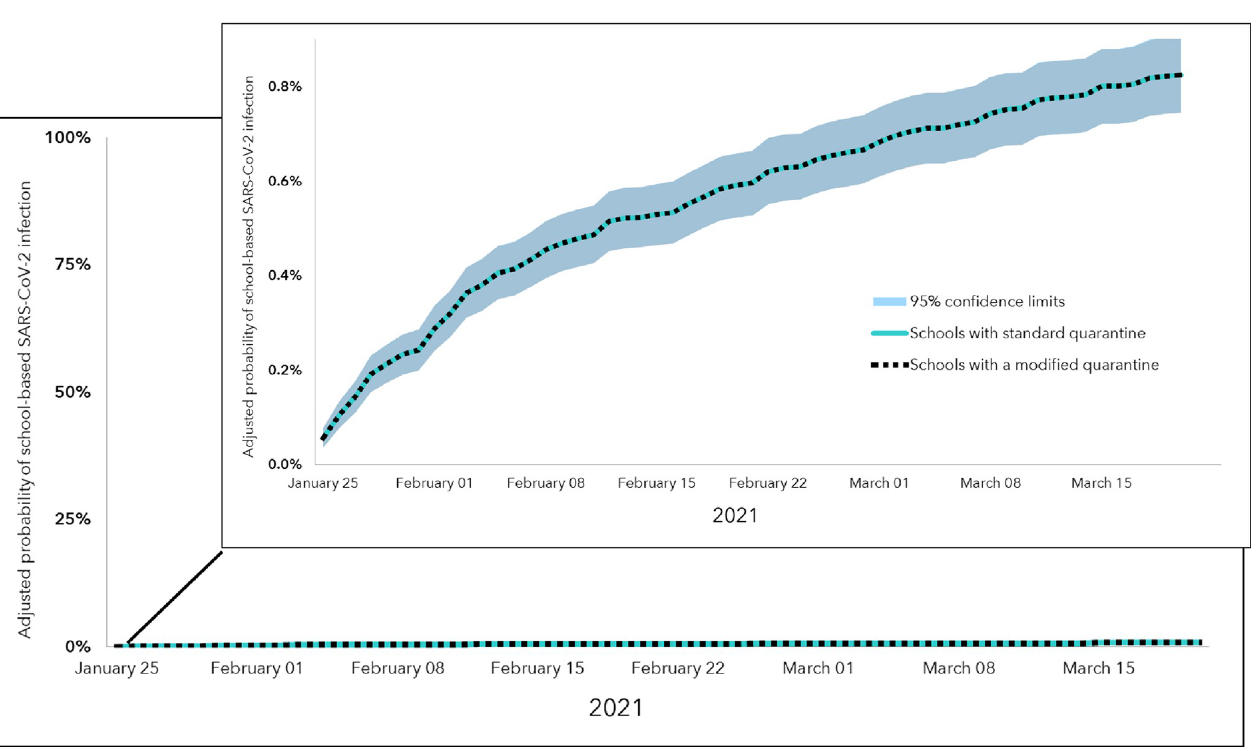
Fig 2. Adjusted probability of school-based SARS-CoV-2 infections based on total projected cases (n = 23) in schools with and without a modified quarantine policy, Greene and St. Louis Counties, Missouri, January 25–March 21, 2021. Top-right inset shows zoomed-in view of adjusted probability curves over the study period. The adjusted � probability curve of school-based SARS-CoV-2 infection in schools with a standard quarantine policy is shown by the teal line; in schools with a modified quarantine policy, it is shown by the dotted black line. The adjusted probability curves and 95% confidence intervals were the same for schools with and without a modified quarantine policy. � The Cox regression model was adjusted for potential school-level confounding factors: quartiles of the percentage of students eligible to receive free or reduced-price lunch (as a proxy for school resources) and the school’s total number of cases that attended school or a school-related event during the study